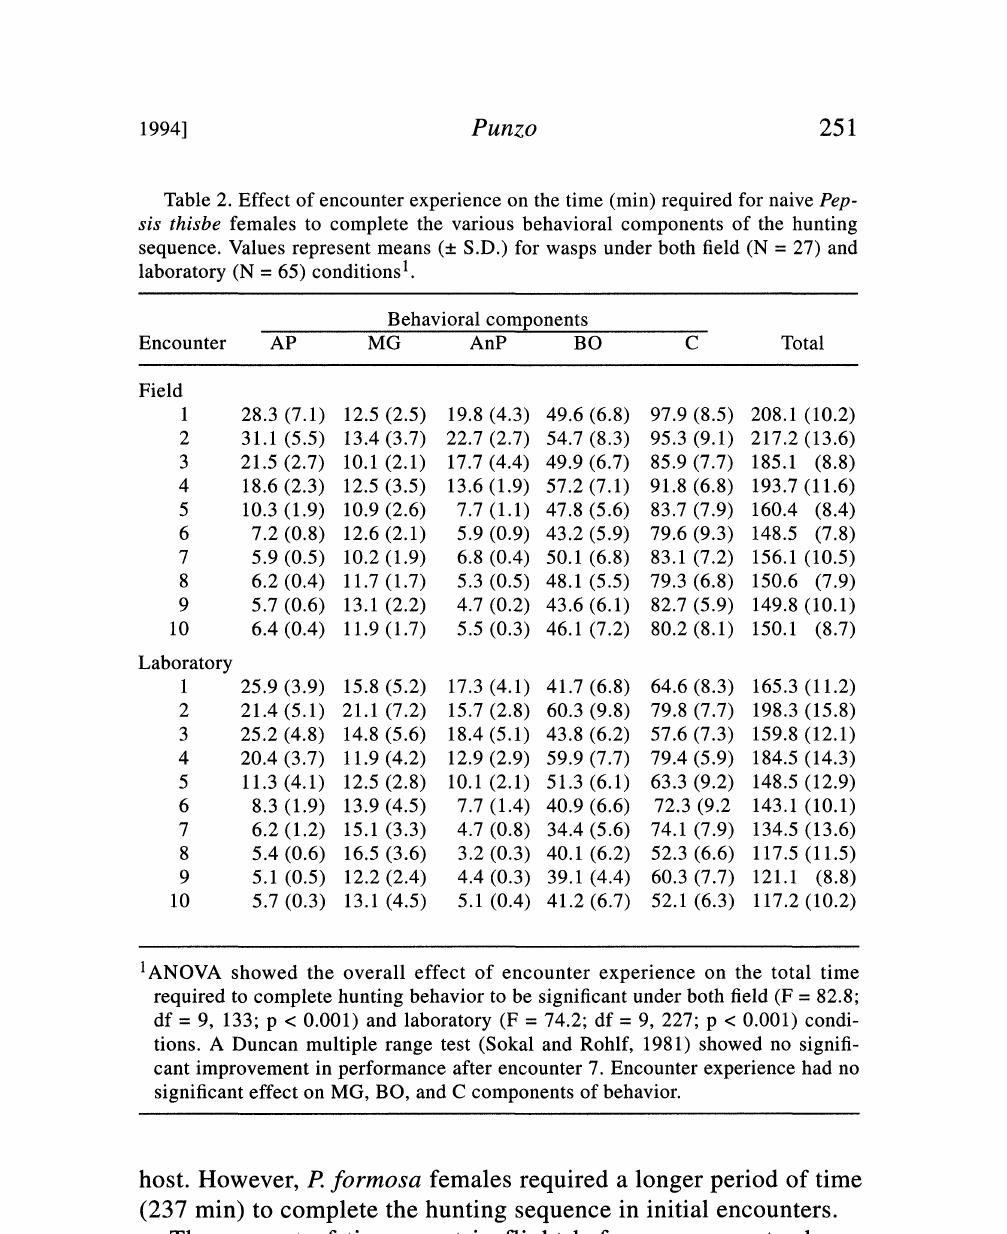
Table 2. Effect of encounter experience on the time (min) required for naive Pep- sis thisbe females to complete the various behavioral components of the hunting sequence. Values represent means (_+ S.D.) for wasps under both field (N 27) and laboratory (N 65) conditions